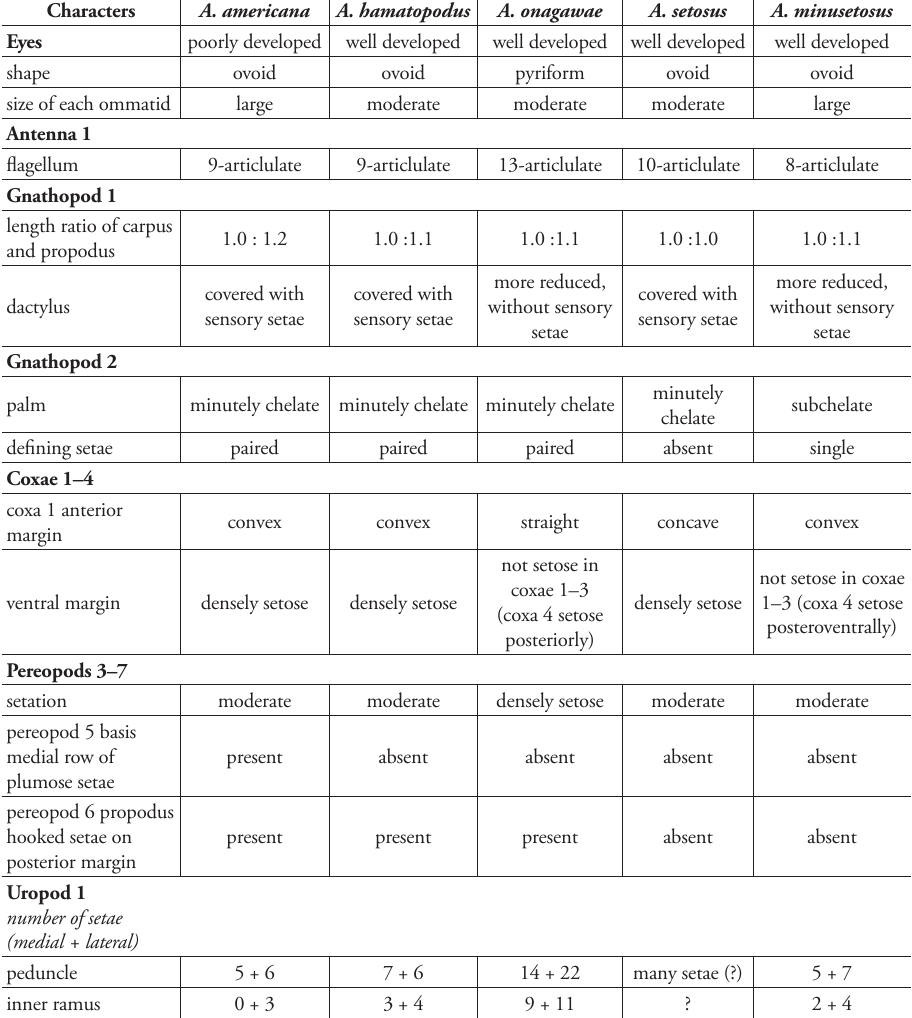
Table 1. Morphological differences between worldwide Aroui